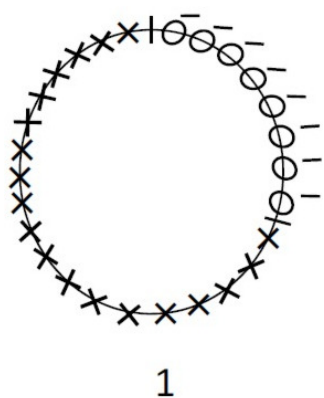
Figure 27 . Dominant term in the case of the cyclic chains with a negative piece.